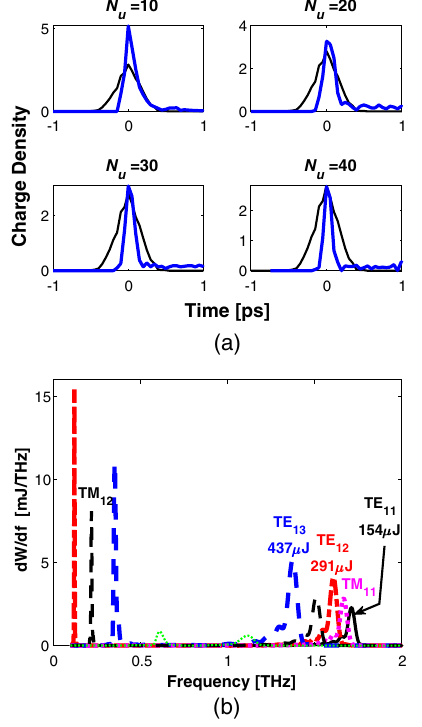
FIG. 4. Negative mass regime (over-resonance guiding field of 75 kG) for a single bunch with a charge of 1 nC: (a) initial and current charge density (the time is given relative to the bunch center; the particle motion to the tail of the distribution shifts the peak from the center of mass) and (b) spectra of the dominant waveguide modes radiated at the fundamental undulator har- monic after N u ¼ 40 undulator periods; the radiation energy is given for high-frequency modes only.